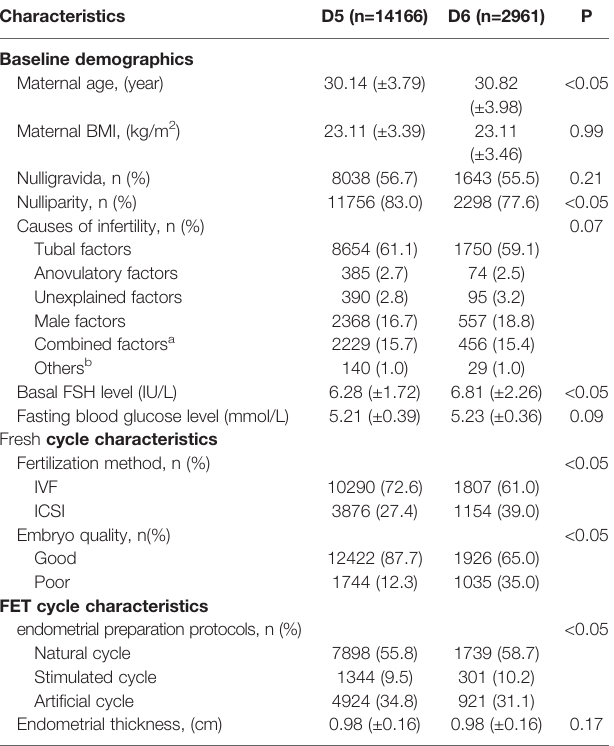
TABLE 1 | Demographics and cycle characteristics.